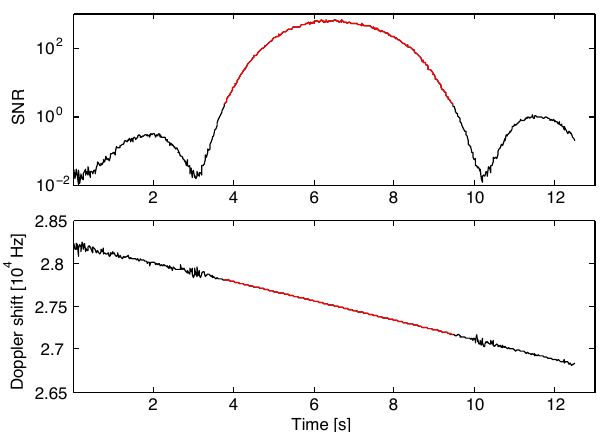
Fig. 2. Example of SNR (top) and Doppler shift (bottom) from a single satellite pass. Curves corresponding to SNR > 2 are plotted in red.